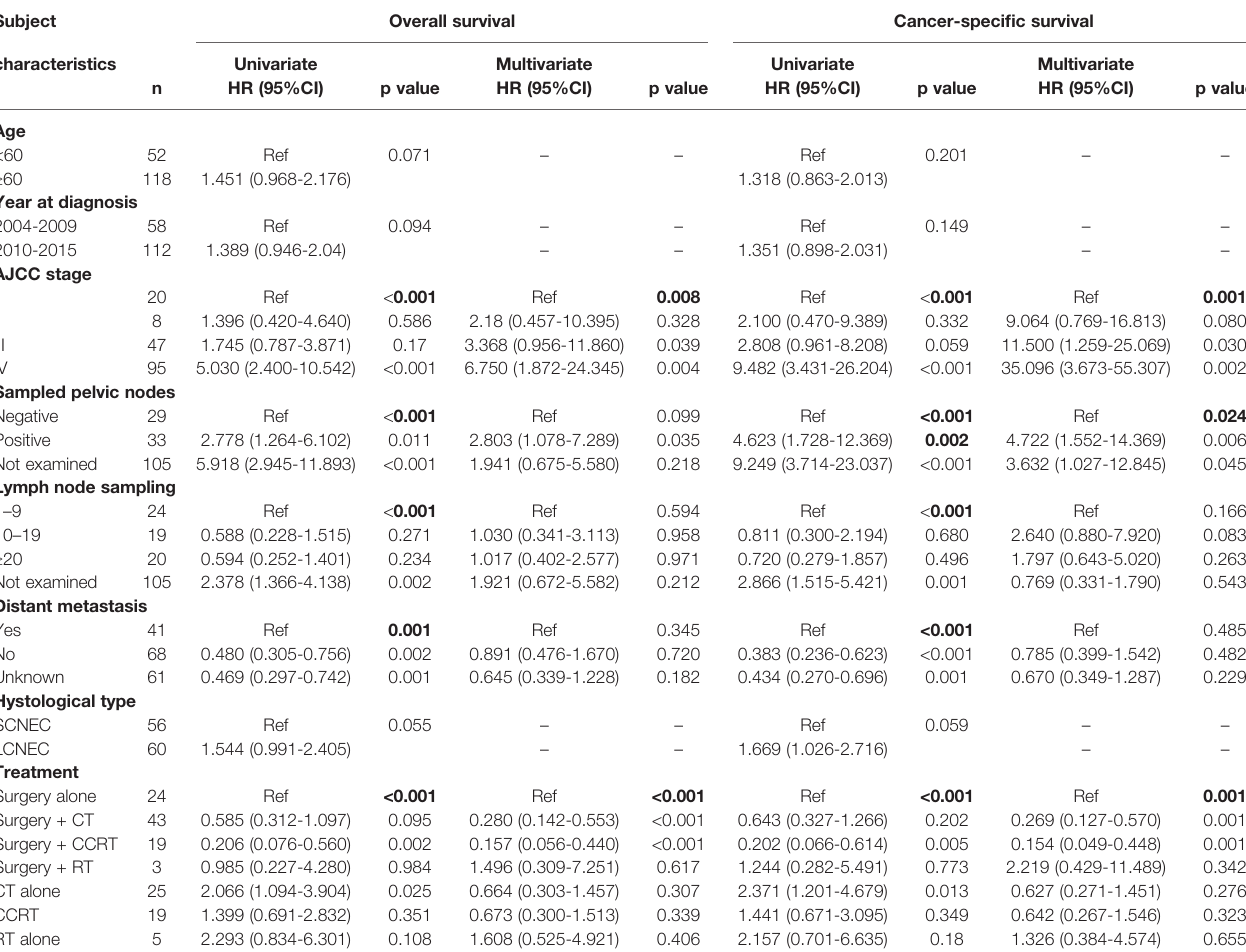
TABLE 3 | Prognostic factors for neuroendocrine tumors (NETs) of the